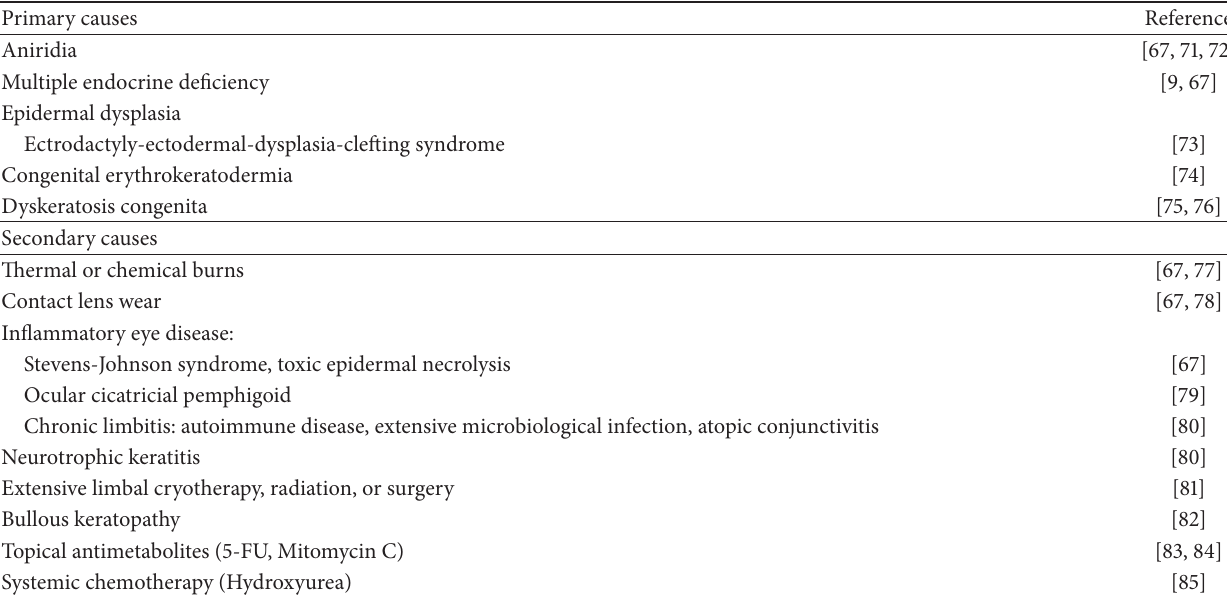
Figure 1: (A) Overview of the anterior surface of the human eye, in which the sclera (with overlying conjunctiva) and cornea can easily be discriminated. (B) The limbus is highly pigmented in some individuals, and allows clear visualization of the limbal palisades of Vogt. The cornea (and underlying dark iris) is pictured above, and conjunctiva (and underlying sclera) below. (C) Diagram of a cross section through the conjunctival, limbal and corneal epithelium. Limbal progenitor cells (a) differentiate into transient amplifying cells (b), post-mitotic cells (c) andfinallyterminallydifferentiatedcells(d).MovementofcellsinX,Y,Zdirectionispresentedbyproliferationofstemcells(a),differentiation and centripetal migration (b, c), and desquamation (d) respectively. Table 1: Aetiology of